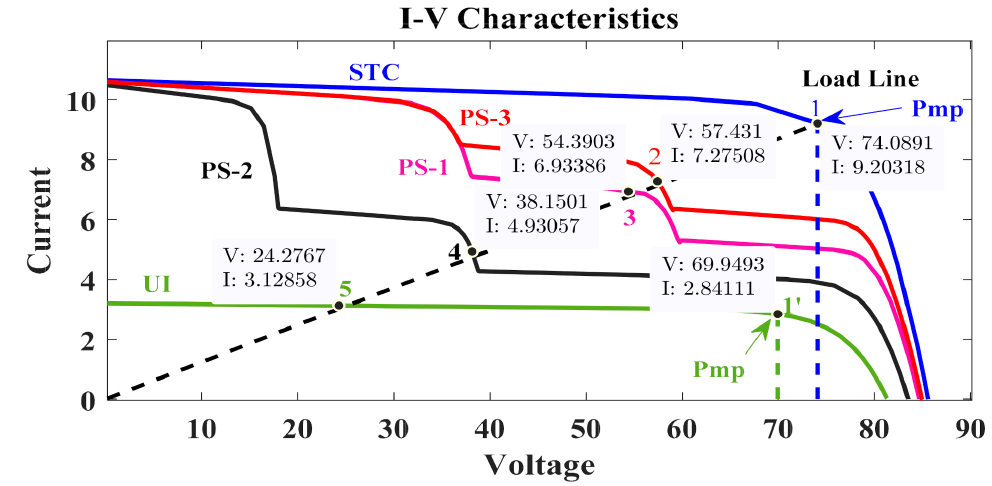
Figure 2. I-V curve during uniform irradiance change and partial